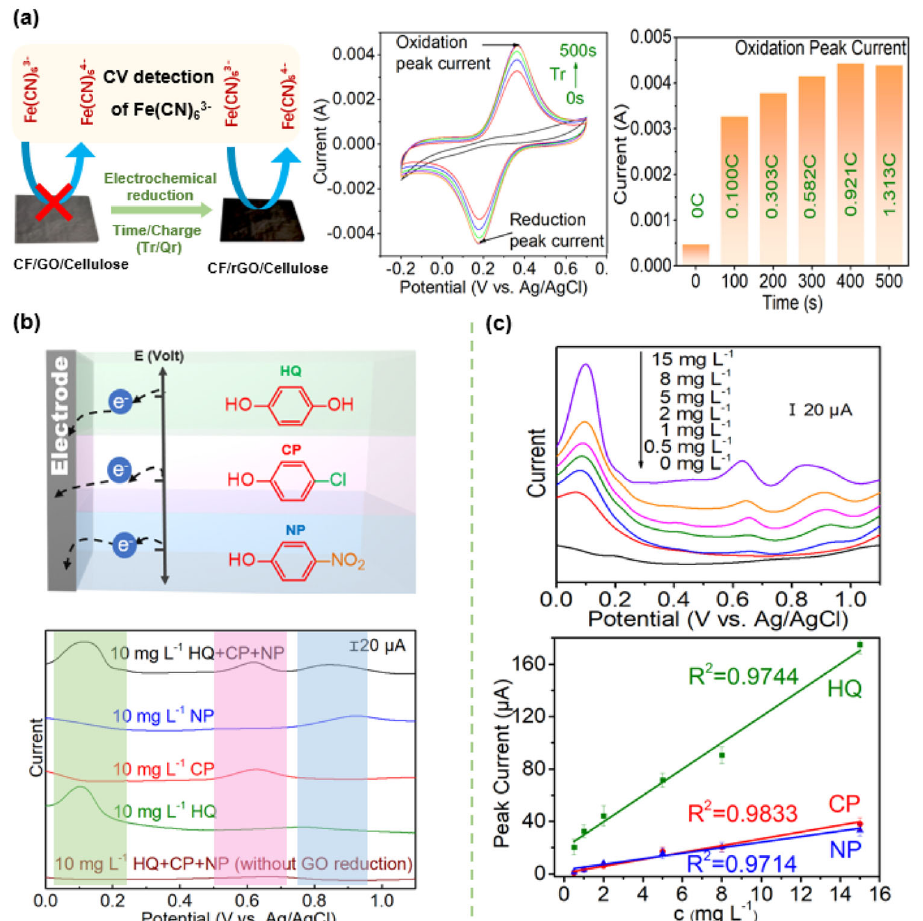
Fig. 5 Electrochemical detection by composite paper. a Electrocatalytic activities. Electrochemical reduction of CF/GO/cellulose confers electrocatalytic activity to the composite (as measured by CV measurements of Fe(CN) 63 − ). Differential pulse voltammetry (DPV) measurements with three phenols (hydroquinone, chlorophenol, and nitrophenol) illustrate that the electrocatalytic properties enhance ( b ) selectivity of electrochemical sensing. Detection selectivity (DPV-peak separation) and ( c ) sensitivity of electrochemical sensing. Detection sensitivity (peak ampli fi cation; error bars show the standard deviation from three measurements and are generally small relative to symbol